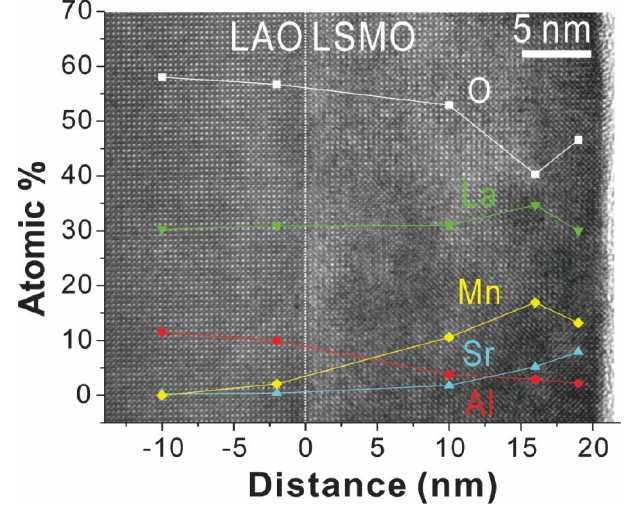
Figure 8. EDS results along the cross section from substrate to the surface of the ECG LSMO thin